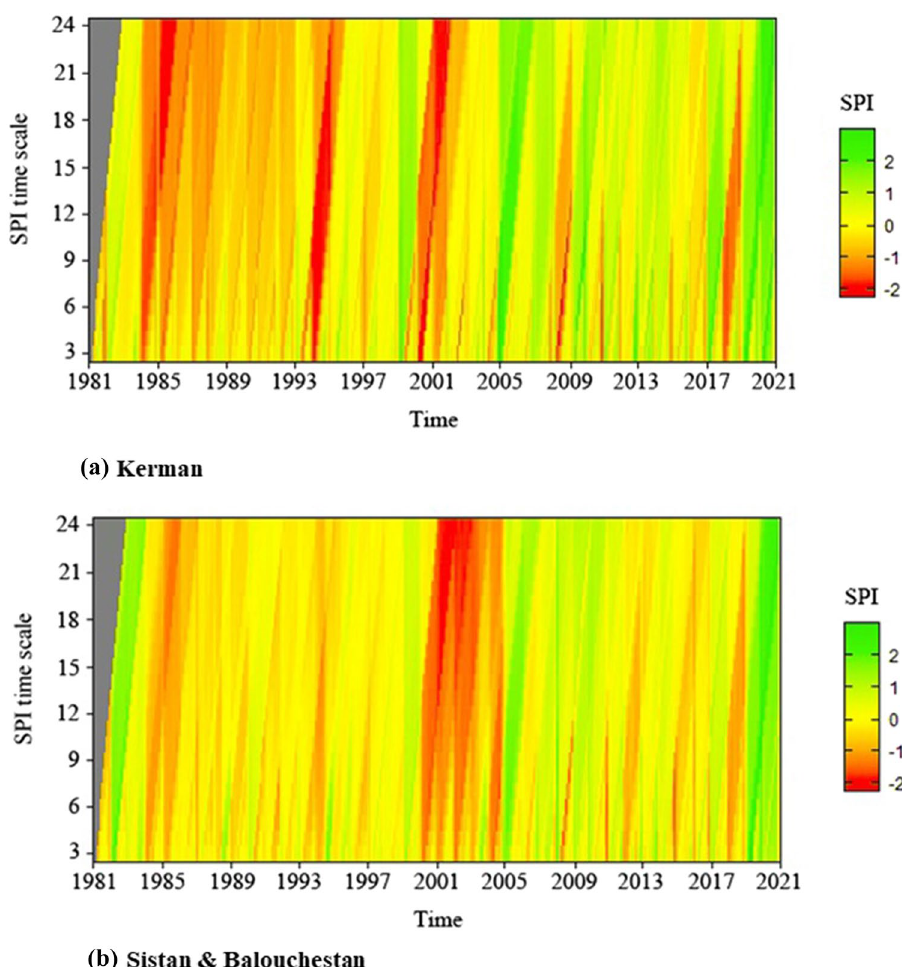
Fig. 7 Hovmöller diagram of SPI-1 to SPI-24 for a Kerman and b Sistan and